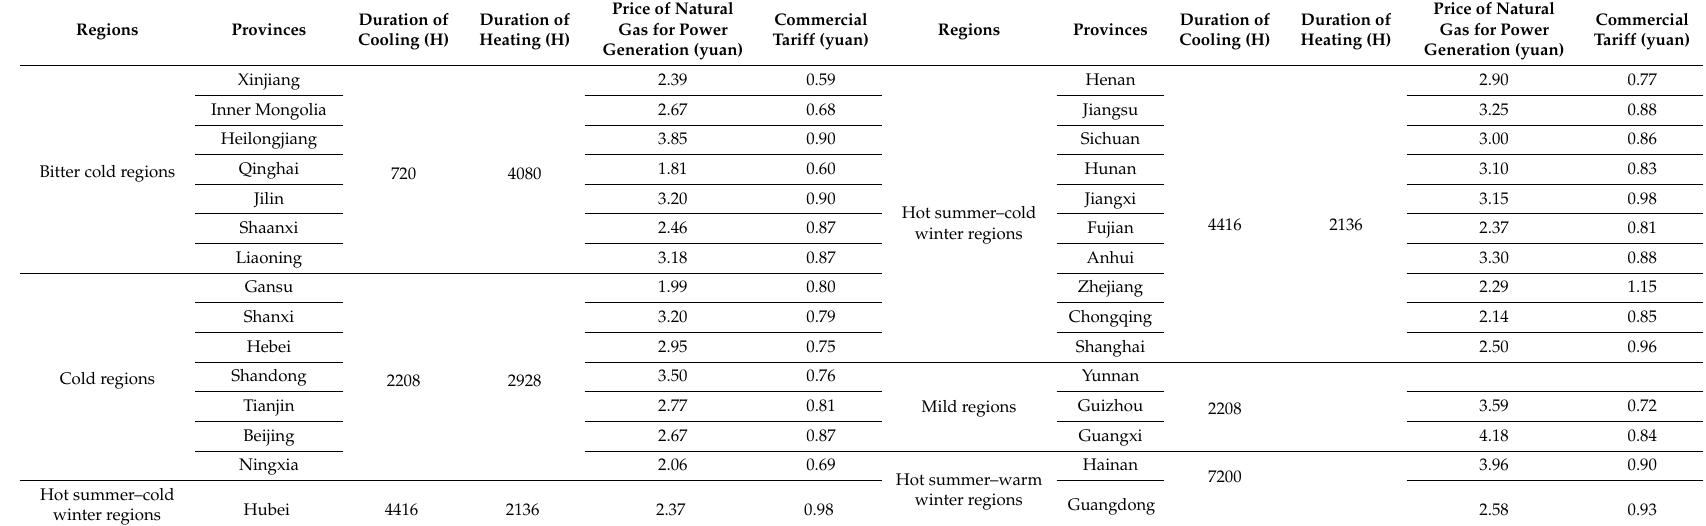
Table 9. Provincial parameters for